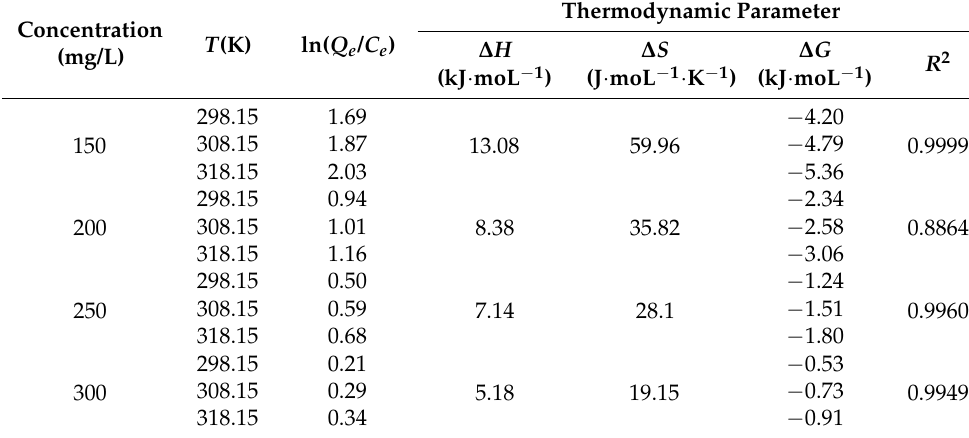
Table 3. Calculated adsorption thermodynamic data of Ce(III) on magnetic PMMA-PGMA-PEI.